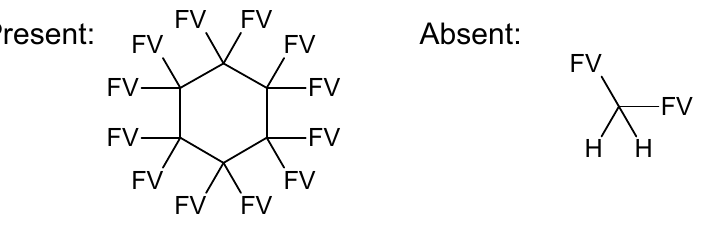
Figure A12. Substructures for GC–MS Challenge 13. FV = free